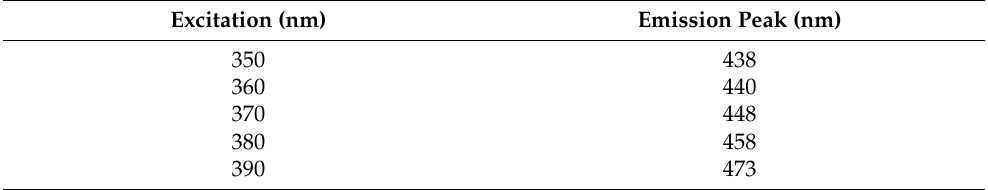
Table 3. Emission peaks recorded within 350–390 nm